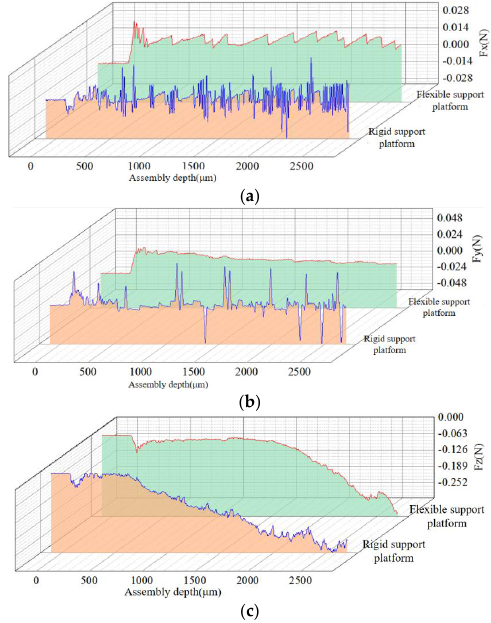
Figure 12. Force state diagram of flexible support platform and rigid support platform in assembly. ( a ) Comparison of radial force of flexible support platform and rigid platform for the first assembly experiment; ( b ) Comparison of radial force of flexible support platform and rigid platform for the second assembly experiment; ( c ) Comparison of axial force of flexible support platform and rigid platform in assembly